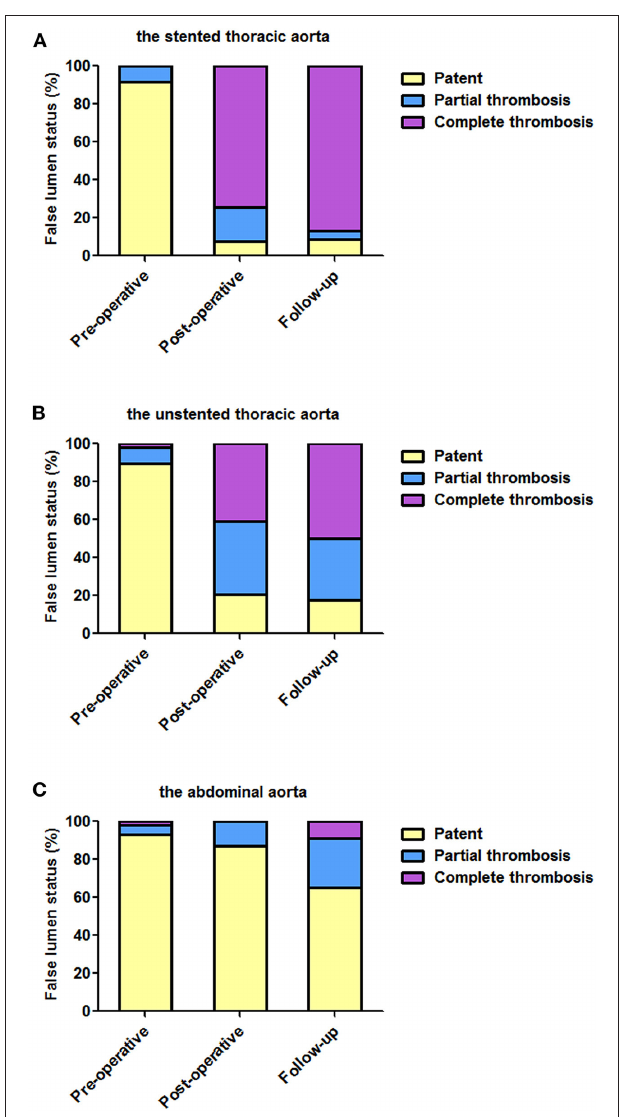
FIGURE 2 | The status of FL over time at different aortic segments. (A) TEVAR induced the complete thrombosis of the stented thoracic FL in most of the patients. (B) After TEVAR, the unstented thoracic FL was completely thrombosed in approximately half of the patients before discharge and during follow-up. (C) FL in the abdominal aorta remained patent in most of the patients at the two post-TEVAR time-points. TEVAR, thoracic endovascular aortic repair; FL, false lumen; TL, true lumen.